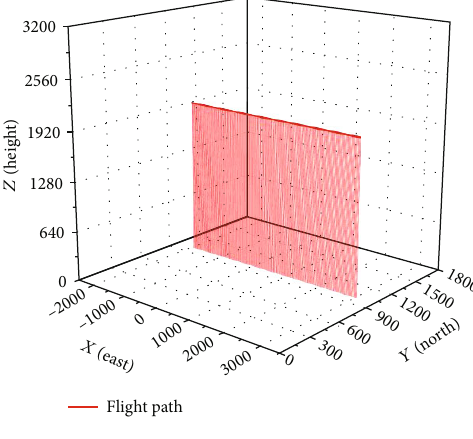
Figure 3: Trajectory of azimuth mutation (uniform).